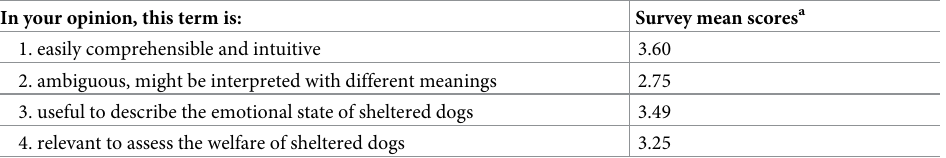
Table 2. Mean scores for the four statements presented in the survey for each term. In your opinion, this term